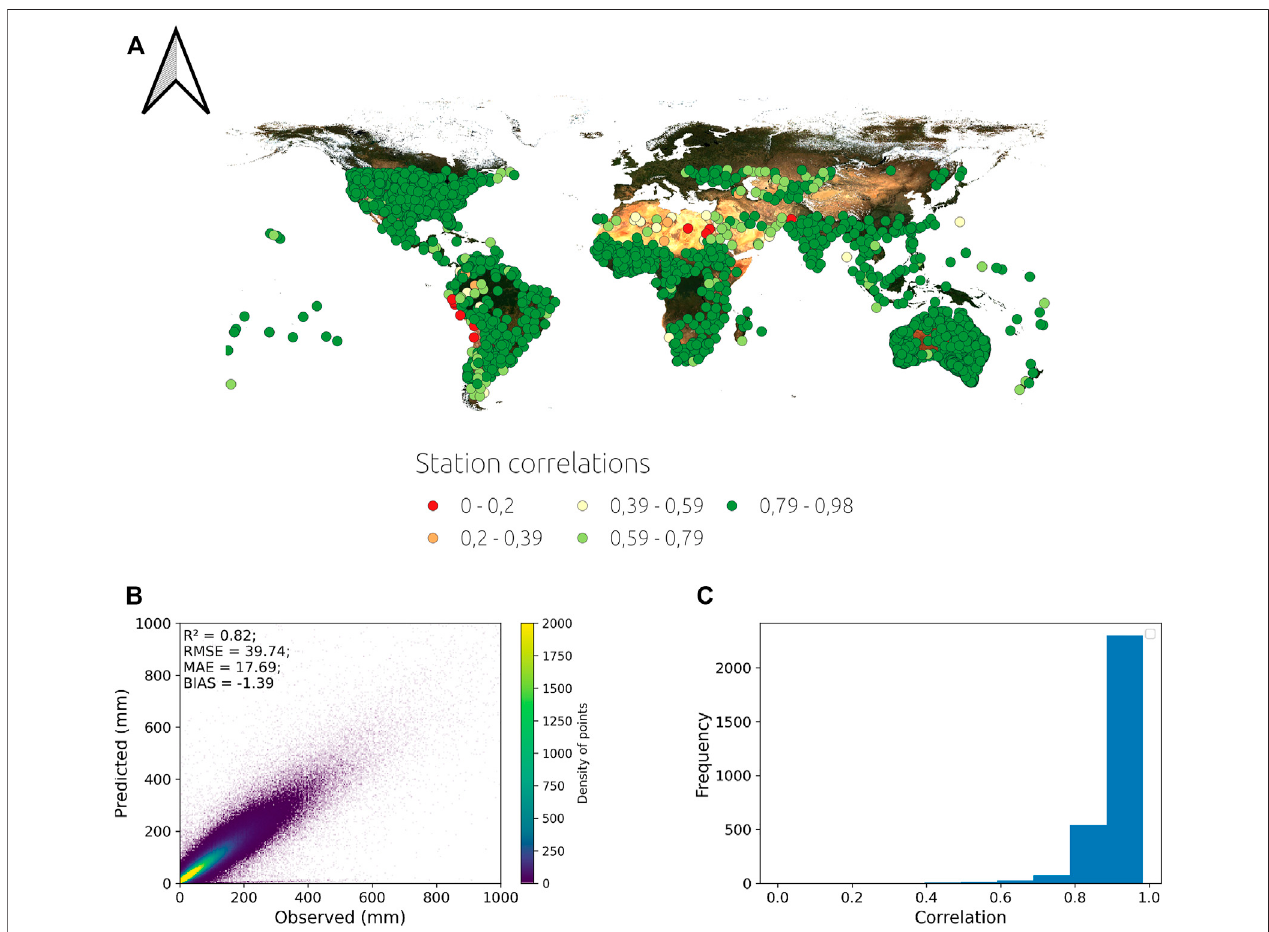
FIGURE 1 | CHIRPS global validation against meteorological stations. The (A) presents a map with the correlation between meteorological stations and CHIRPS. The (B) presents a density scatter plot with monthly observations and predictions for all stations, while the (C) shows the histogram of the correlations.